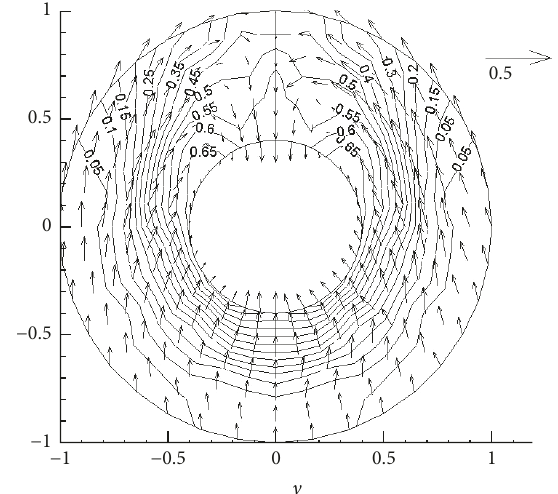
Figure 9: Wake field at propeller